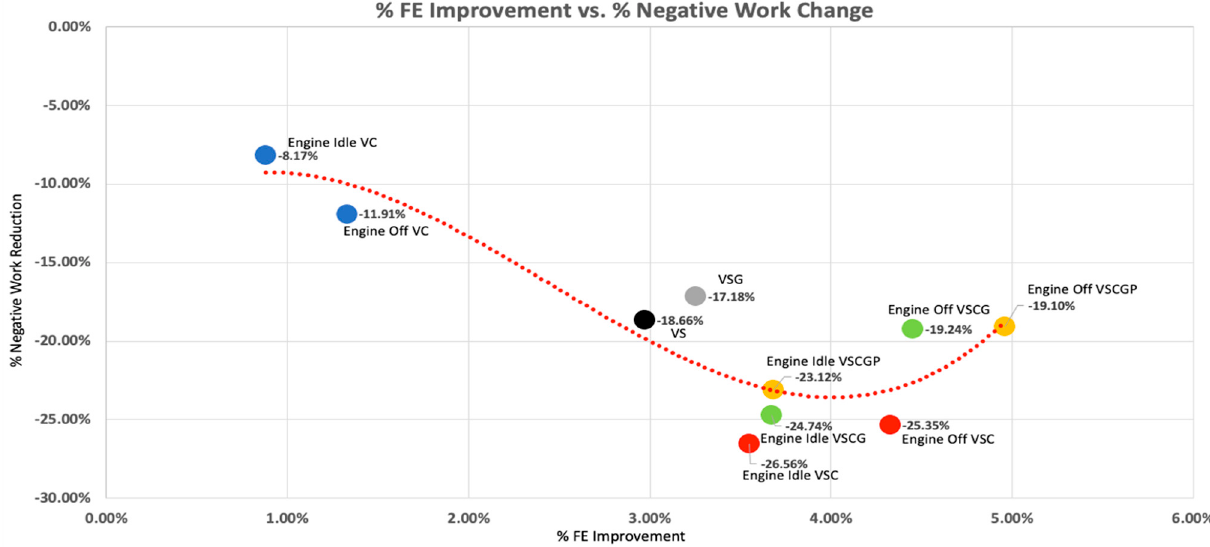
Figure 14. % Reduction in negative work as a function of % fuel economy improvement for various optimal problem setups.